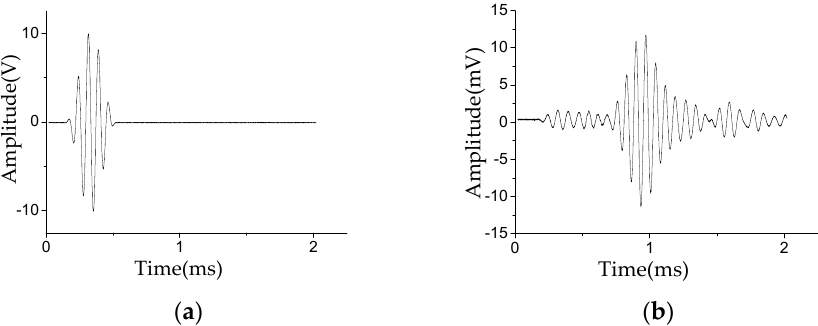
Figure 7. Signal waveforms: ( a ) Lamb wave excitation signal; ( b ) Lamb wave health signal H (t).